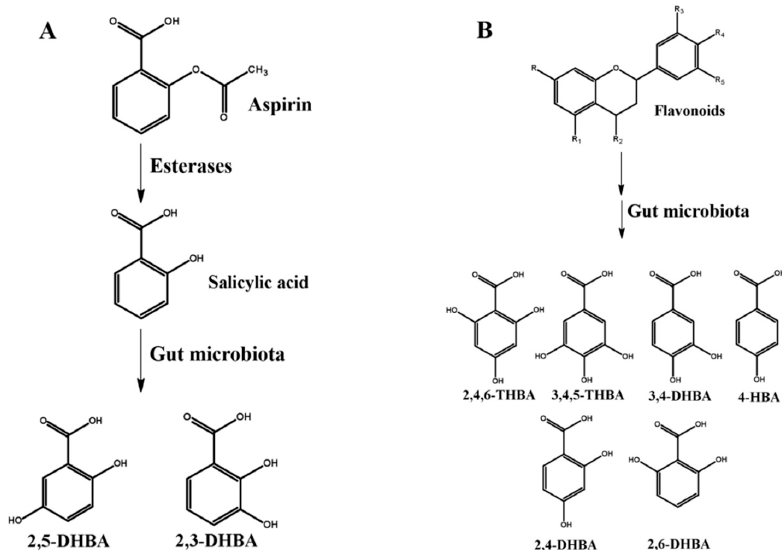
Figure 2. Metabolism of aspirin and flavonoids to generate hydroxybenzoic acids. ( A ) Aspirin metabolism generates 2,3-dihydroxybenzoic acid (2,3-DHBA) and 2,5-DHBA through CYP450 reactions in the liver [61]. DHBAs have also been shown to be generated through microbial metabolism of aspirin/salicylic acid [12]. ( B ) Flavonoid metabolism generates metabolites 2,4,6-trihydroxybenzoic acid (2,4,6-THBA), 3,4-DHBA, 3,4,5-THBA, 4-HBA, 2,4-DHBA, 2,6-DHBA through microbial degradation in the intestine [11,45,56,58]. R-R5 represent various functional groups (example -hydroxy, -ketone, -hydrogen, -methoxy, etc.) that are appended / attached to the flavonoid backbone to generate different groups of